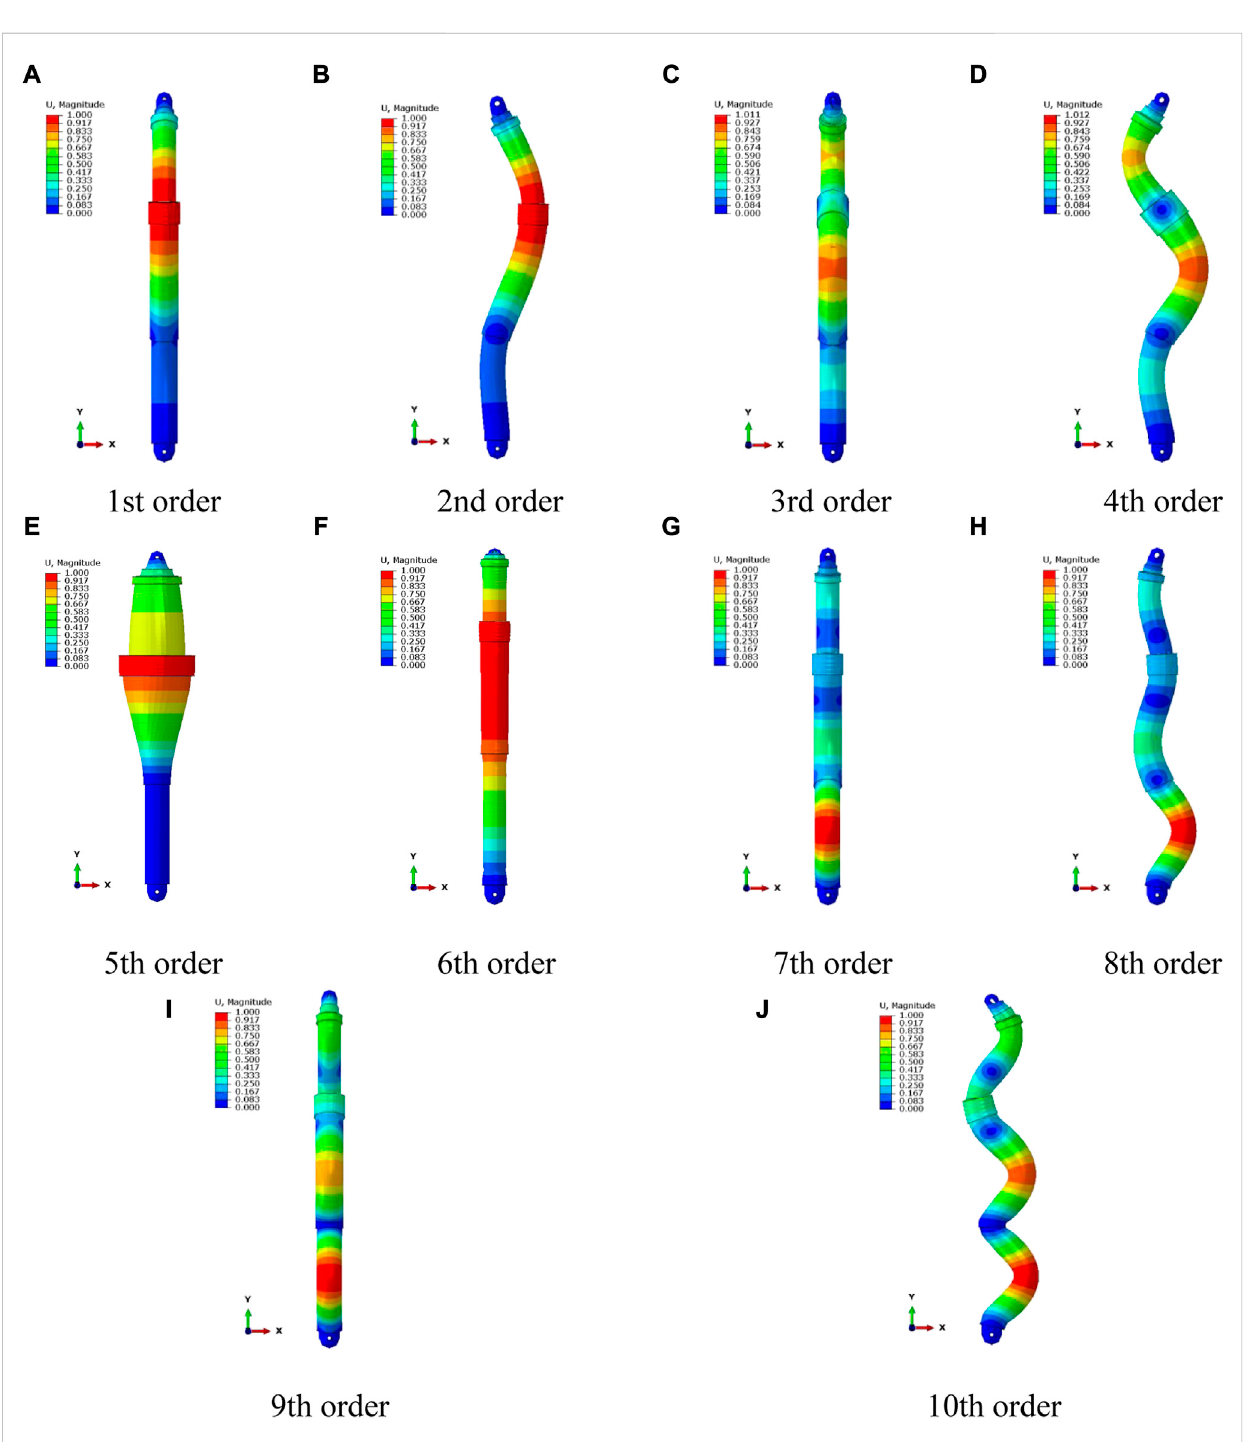
FIGURE 11 Vibrational mode diagram for the fi rst ten orders of the conventional column (A – J)